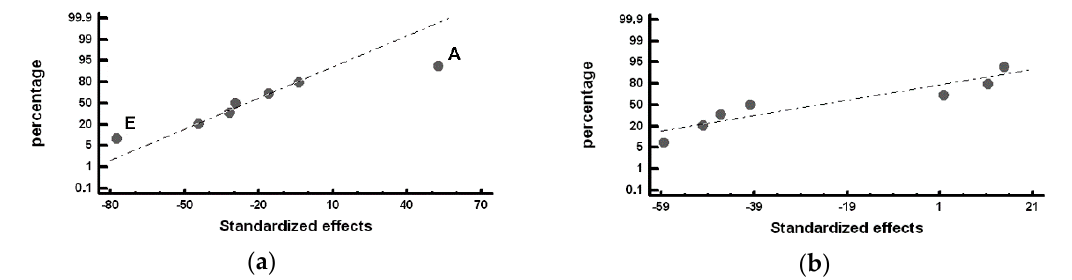
Figure 3. Standardized effects on the number of counts per mm 2 of graphite, N A , on a normal probability plot: ( a ) Factors with a significant effect on the outermost region of the working layer (Zone α ); ( b ). Factors with a significant effect on the inner region of the working layer (Zone β ).